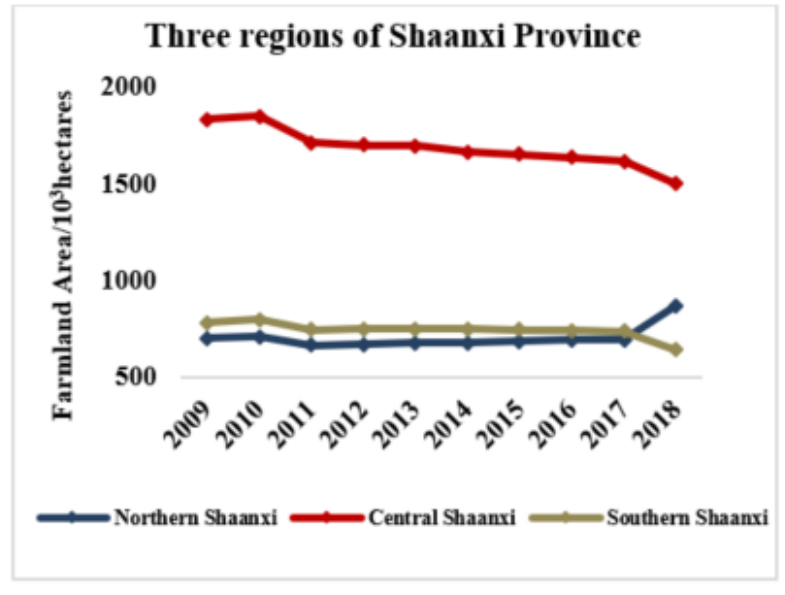
Figure 4. Farmland area in Shaanxi Province (2009–2018).